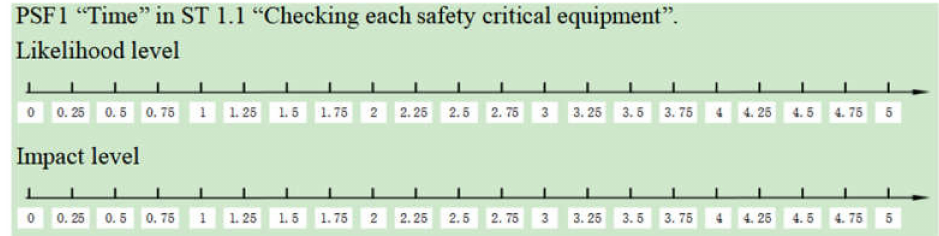
Figure 7. Example question in the questionnaire.